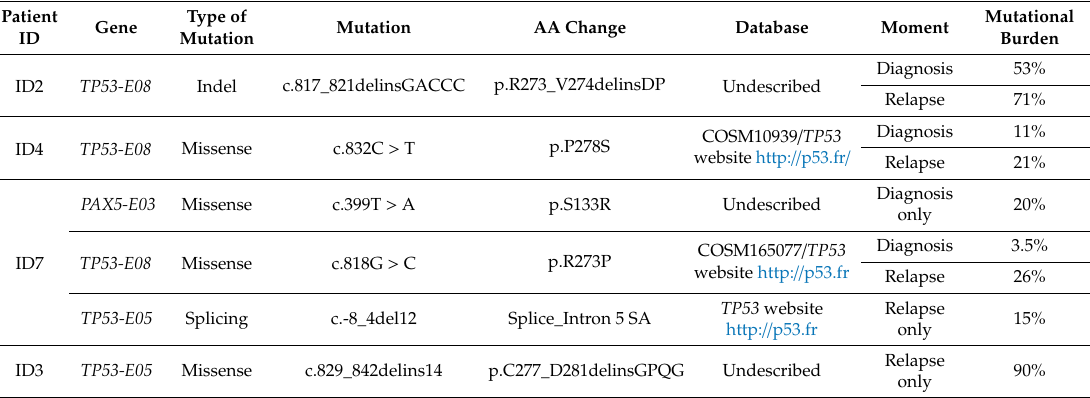
Table 2. Description of somatic mutations observed in diagnosis–relapse BCP-ALL patients. All three TP53 mutations retained at relapse increased their mutational burden to relapse (c.818G > C from 3.5% to 26%, c.832C > T from 11% to 21% and 817_821delinsGACCC from 53% to 71%).